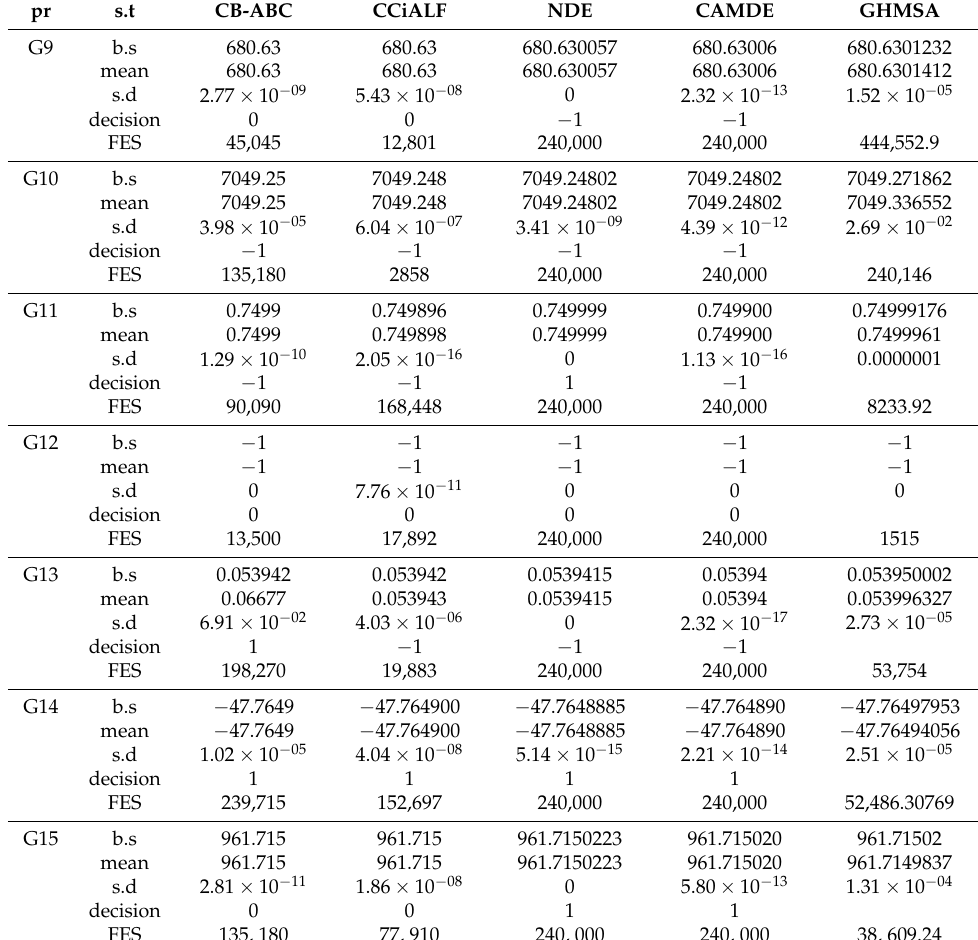
Table 9. Comparison of results for test problems G09 to